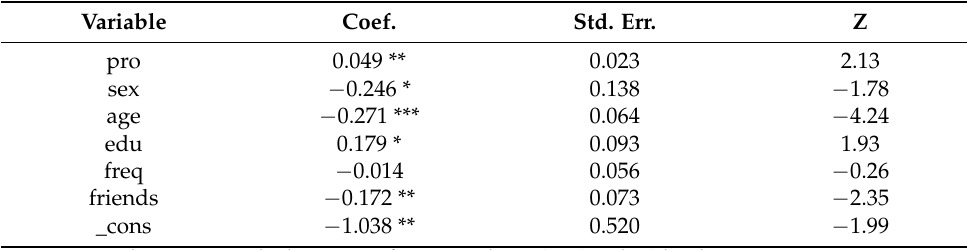
Table 4. Results of the logit regression